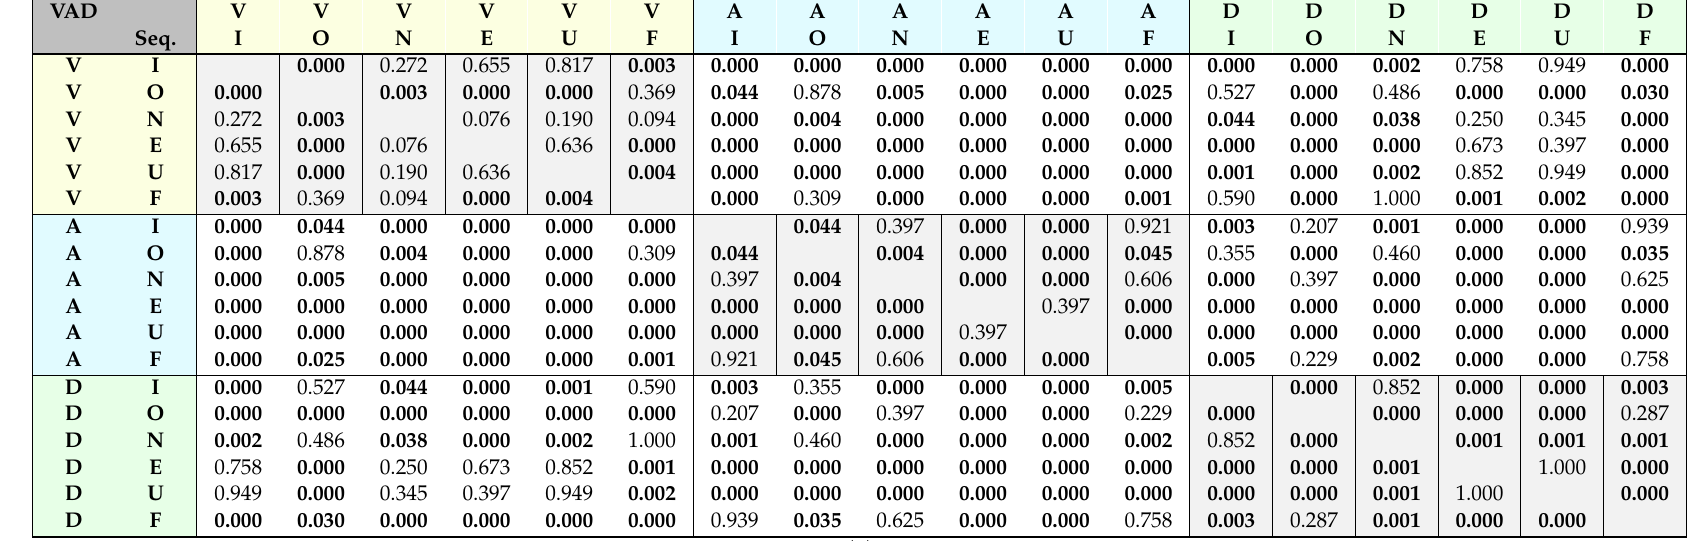
Table A1. ( a ) Newman-Keuls post-hoc corrections for the VAD dimensions (V = Valence; A = Arousal; D = Dominance) of the SAM Ratings and the six sequences Seq. (I = Interest , O = Overload , N = Normal , E = Easy , U = Underload , F = Frustration ) for Group A. Significant e ff ects are highlighted in bold ( p < 0.05). ( b ) Newman-Keuls post-hoc corrections for the VAD dimensions (V = Valence; A = Arousal; D = Dominance) of the SAM Ratings and the six sequences Seq. (I = Interest , O = Overload , N = Normal , E = Easy , U = Underload , F = Frustration ) for Group A + Group B1. Significant e ff ects are highlighted in bold ( p < 0.05).